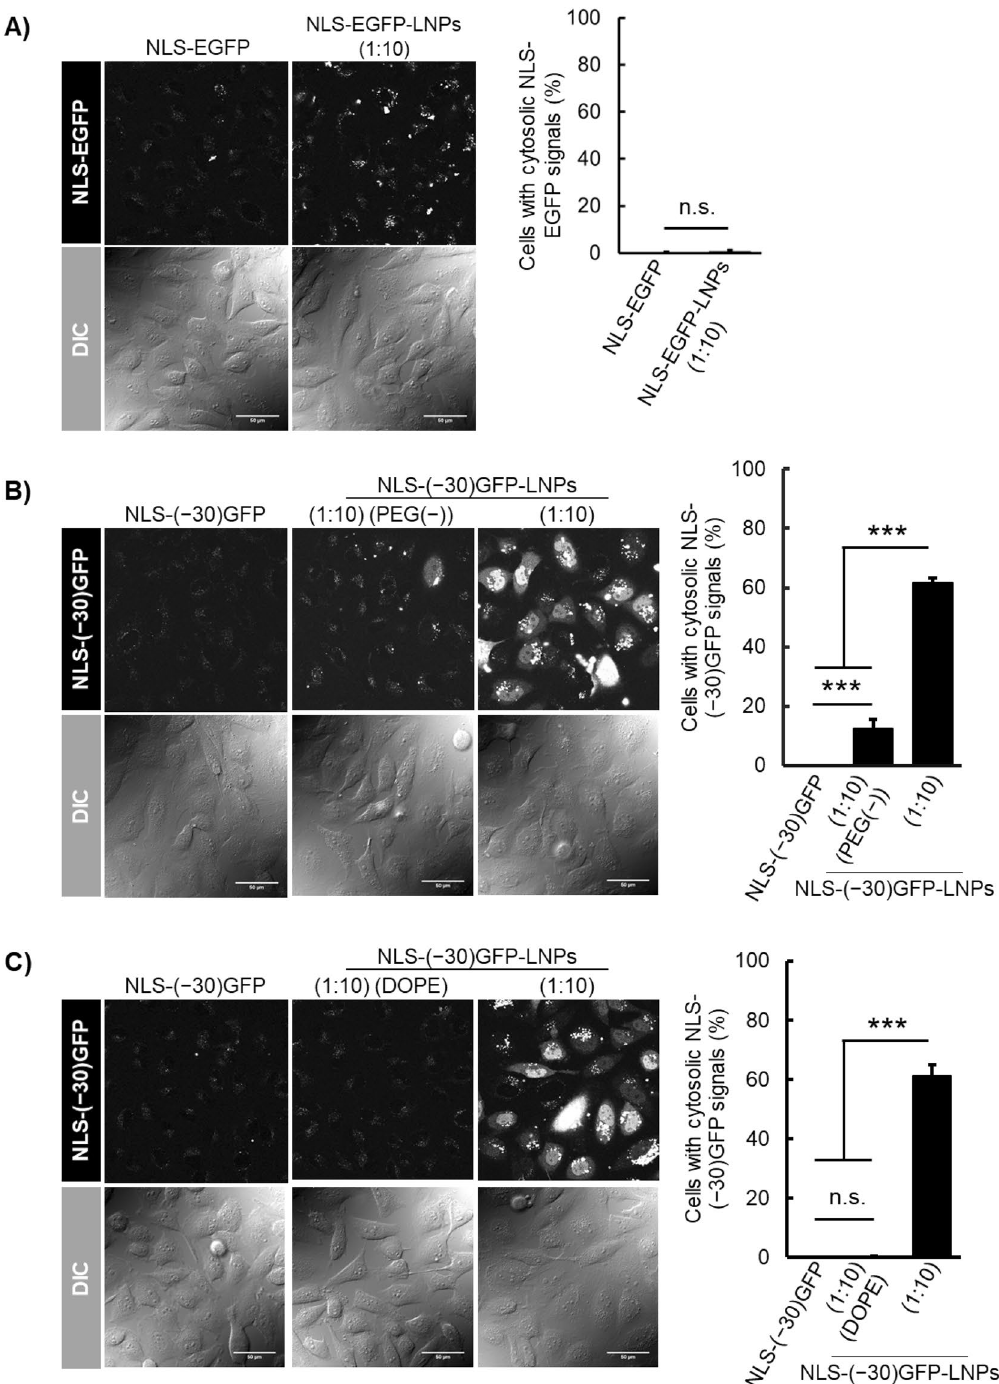
Figure 4. CLSM of cells treated with protein-encapsulating LNPs and the percentages of cells having cytosolic/ nuclear localization of the proteins 6 h after treatment with the following: ( A ) NLS-EGFP alone (left) and NLS- EGFP-LNPs (1:10) (right); ( B ) NLS-(− 30)GFP alone (left), NLS-(− 30)GFP-LNPs (1:10) (PEG(–)) (center), and NLS-(–30)GFP-LNPs (right); ( C ) NLS-(− 30)GFP-LNPs (1:10) (DOPE) (center), and NLS-(–30)GFP-LNPs). The percentages of cells bearing cytosolic NLS-EGFP/NLS-(− 30)GFP signals are presented as the mean ± SD (n = 3). n.s., not significant; *** P < 0.001 (one-way analysis of variance (ANOVA) followed by Tukey–Kramer’s honestly-significant difference test). Protein concentration, 2.5 µM. Concentration of LNPs were set to yield 2.5 µM NLS-EGFP or NLS-(− 30)GFP when hypothesized that all the employed proteins for LNP preparation was encapsulated into the